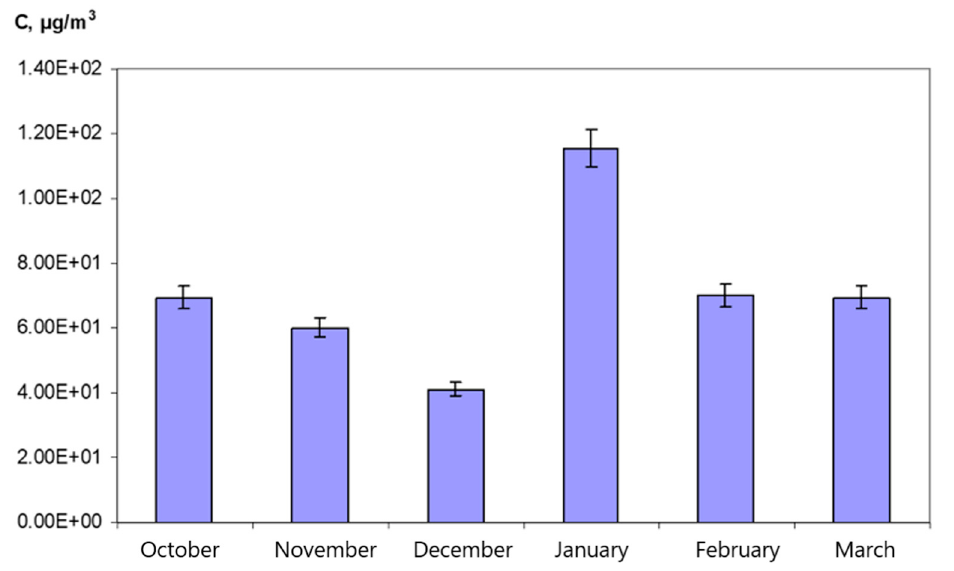
Figure 1. Distribution of daily PM 10 concentrations ( µ g/m 3 ) in Chelyabinsk city in autumn-winter season 2020–2021.